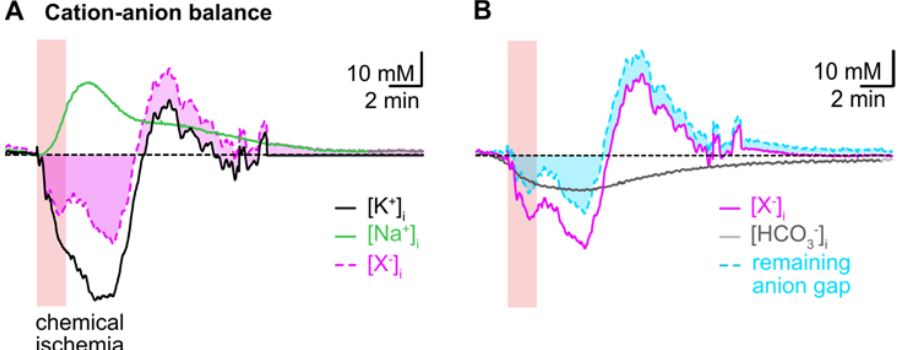
Figure 6. Intracellular cation–anion balance. ( A ) Subtraction of the averaged trace for changes in [Na + ] i (green trace) from that calculated for [K + ] i (black trace) reveals a biphasic anion gap (pink trace and area) induced by chemical ischemia. ( B ) Subtraction of the calculated changes in [HCO 3 − ] i during chemical ischemia (grey trace) reduces the remaining anion gap in the initial phase and increases it in the second phase of recovery (cyan trace and area).